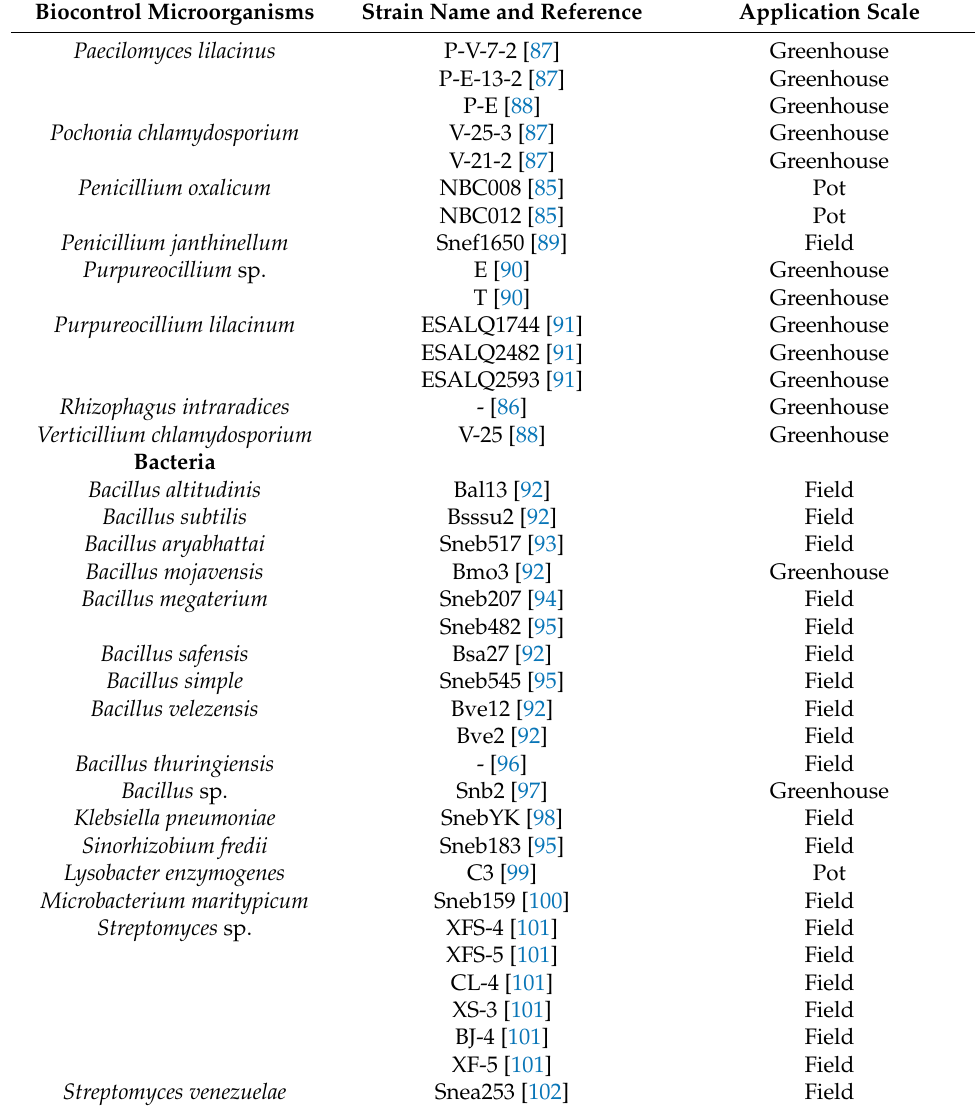
Table 3. Cont. Biocontrol